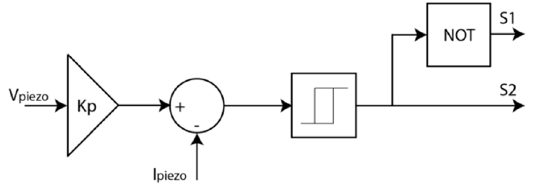
Figure 5. Control design for the piezoelectric system.